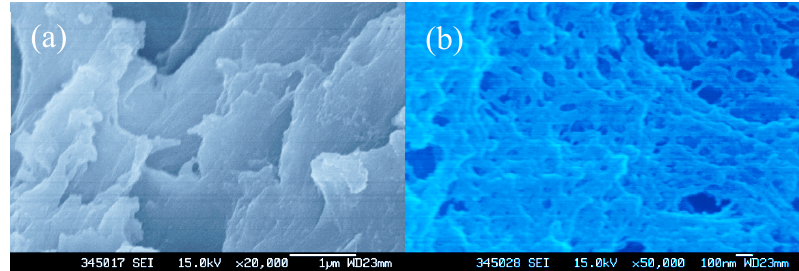
Figure 3. SEM images of CGC: ( a ) low magnificationand ( b ) high magnification.